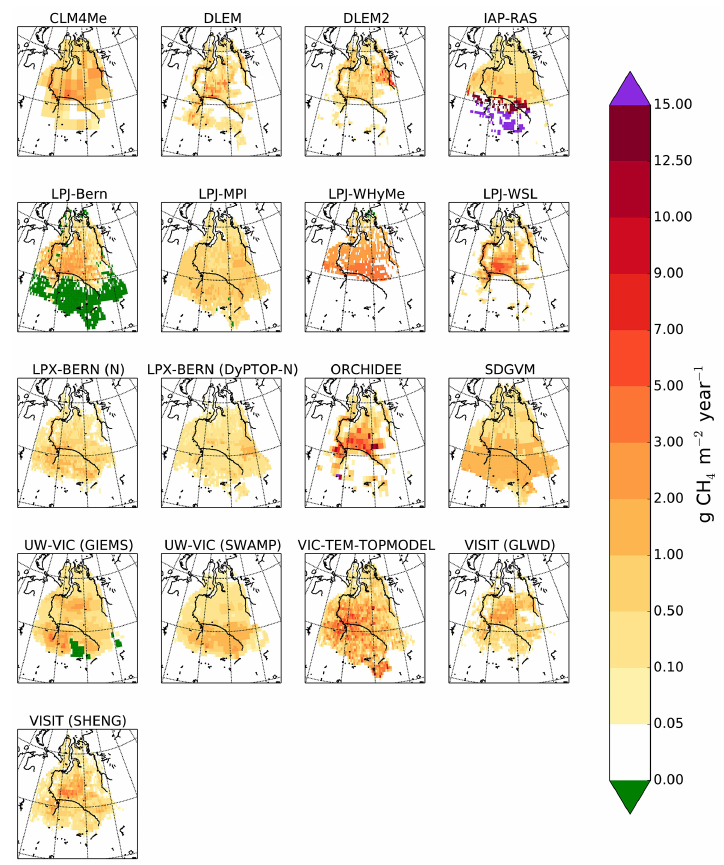
Figure 6. Maps of simulated average annual CH 4 emissions (gCH 4 m − 2 yr − 1 of grid cell